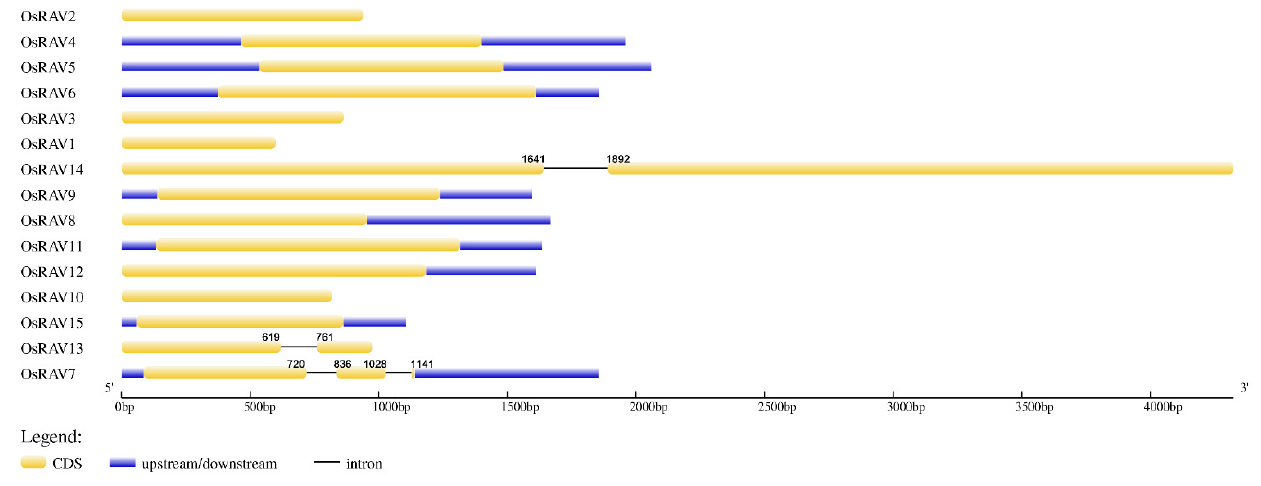
Figure 3. The exon–intron structure of the rice RAV genes. The exon–intron structures were generated using the GSDS online tool. The exons, introns, and untranslated regions (UTRs) are represented by yellow boxes, black lines, and blue boxes, respectively.